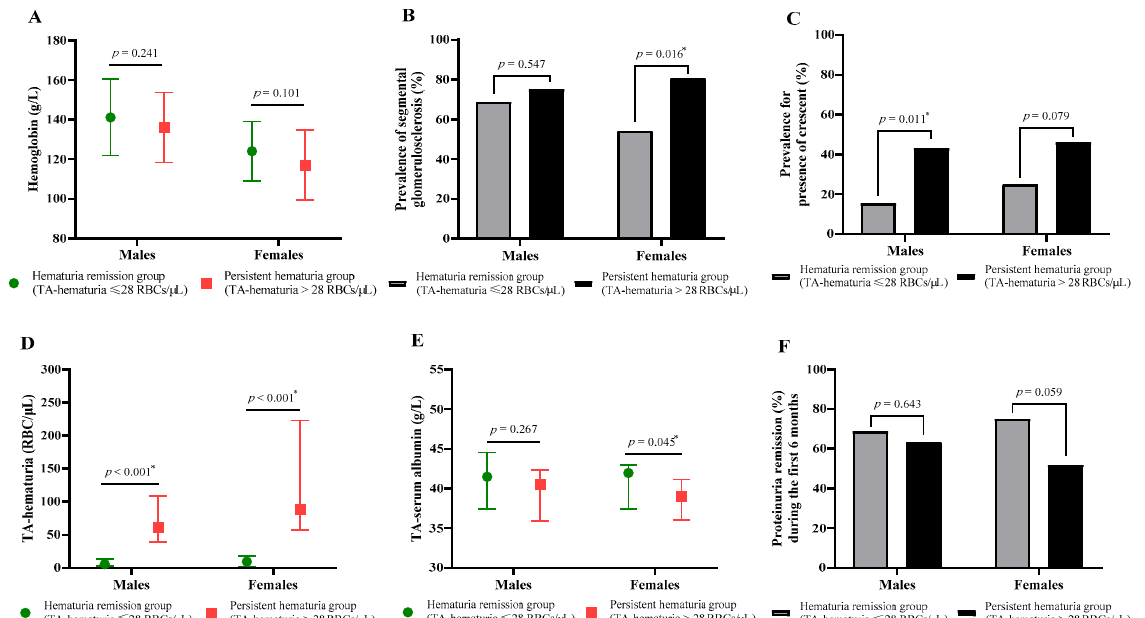
Figure 2. Comparison of clinicopathological data and the clinical data during follow-up and whether proteinuria remission of IgA nephropathy participants between hematuria remission and persistent hematuria groups in males and females. ( A ) Estimated glomerular filtration rate (eGFR); ( B ) the prevalence of segmental glomerulosclerosis (S1); ( C ) the prevalence for presence of crescent (C1–2); ( D ) TA-hematuria; ( E ) TA-serum albumin; ( F ) the present of proteinuria remission during first 6 months. * Two-tailed p < 0.05.